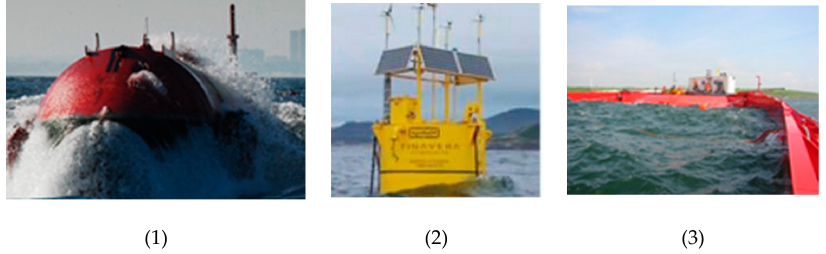
Figure 5. Types of devices studied: Pelamis (1) [62], AquaBuoy (2) [63] and Wave Dragon (3) [64].